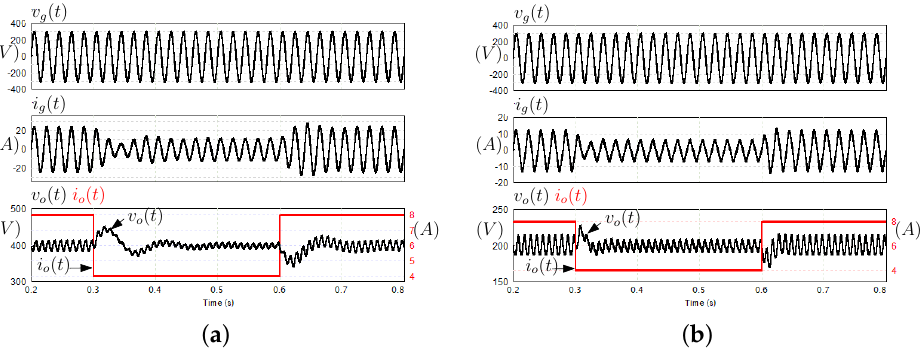
Figure 20. Output current transient waveforms of input voltage v g ( t ) , input current i g ( t ) , out- put voltage v o ( t ) and the output current i o ( t ) from full power to half power for: ( a ) Boost mode. ( b ) Buck